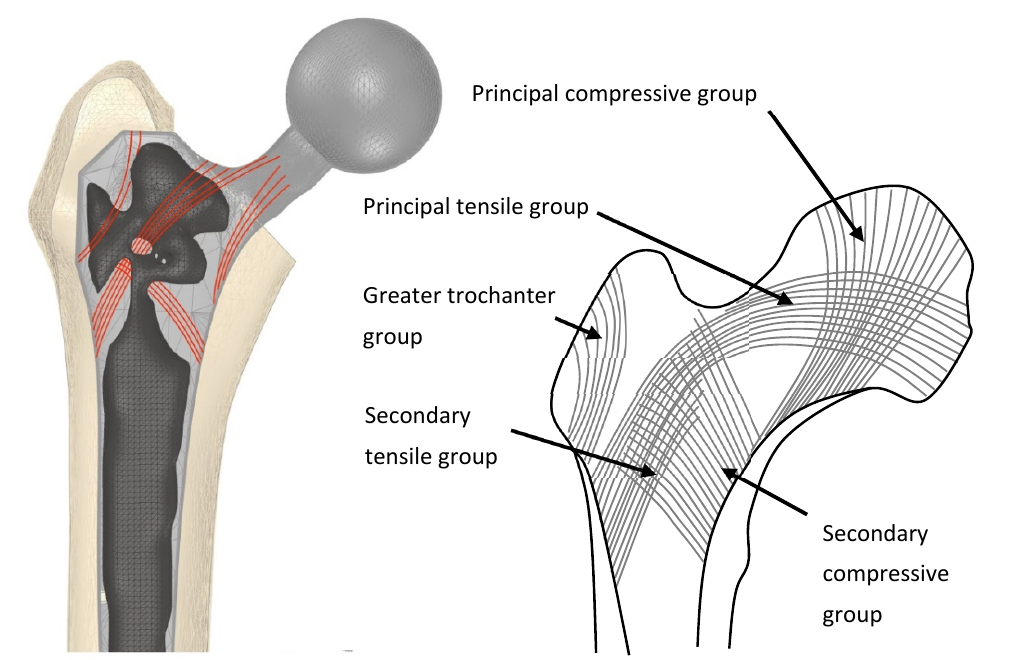
Figure 5. The successfully manufactured solid (left), porous (middle) and selectively hollowed (right) hip implants. The solid and selectively hollowed implants look identical. Thus, a clear resin plastic version of the selectively hollowed implant is also shown to indicate the internal structure of the selectively hollowed implant (right).